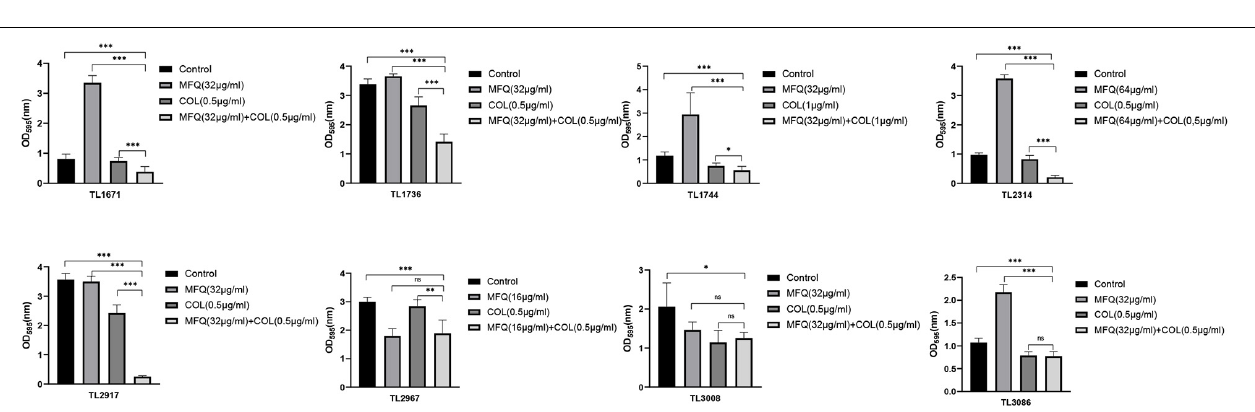
FIGURE 1 | Time kill curve result diagram. Time-killing curves of colistin and mefloquine alone or in combination against Colistin-resistant P. aeruginosa . Mefloquine (MFQ) and colistin (COL).